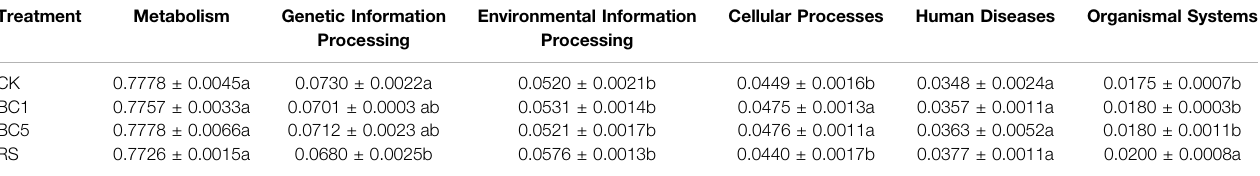
TABLE 3 | The relative abundance of information on primary function of the soil bacterial community.